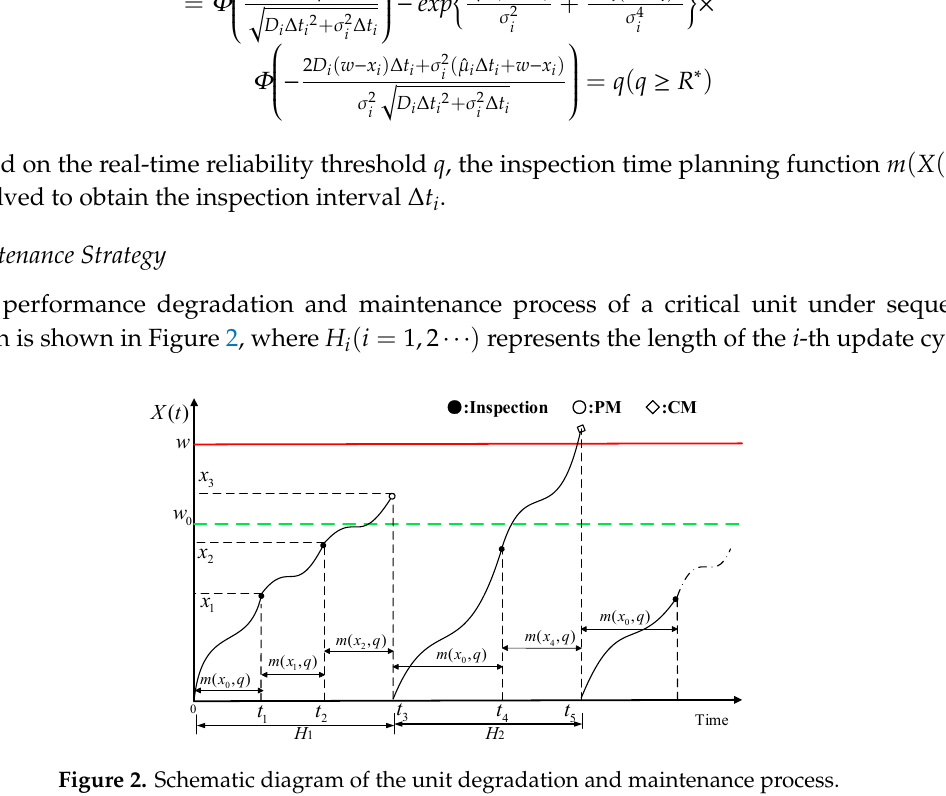
Figure 2. Schematic diagram of the unit degradation and maintenance process.